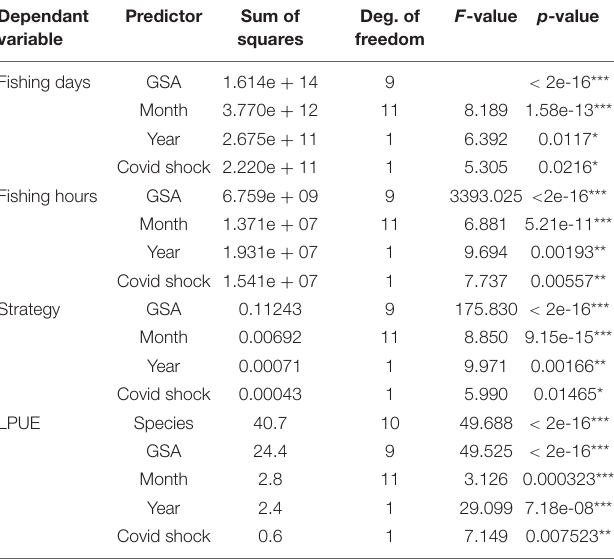
TABLE 4 | Results of the ANOVA applied on the different indicators (Fishing Days, Fishing Hours, Strategy, LPUE). Dependant Predictor Sum of Deg. of F -value p variable squares freedom